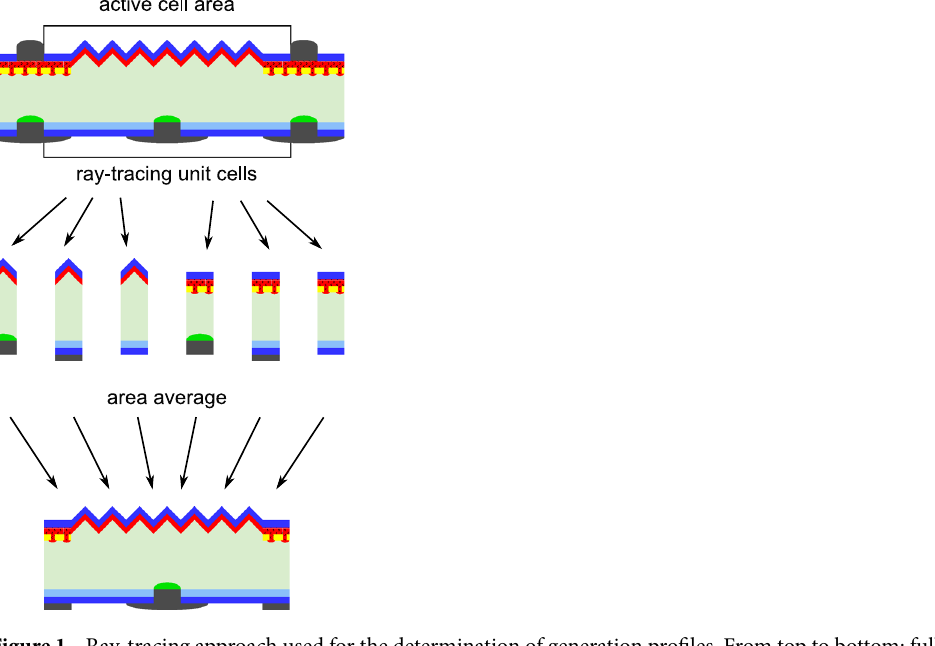
Figure 1. Ray-tracing approach used for the determination of generation profiles. From top to bottom: full cell structure with active cell area marked, the six unit cells required for the optical simulation of the example structure and area averaging for a charge carrier generation profile of the active cell